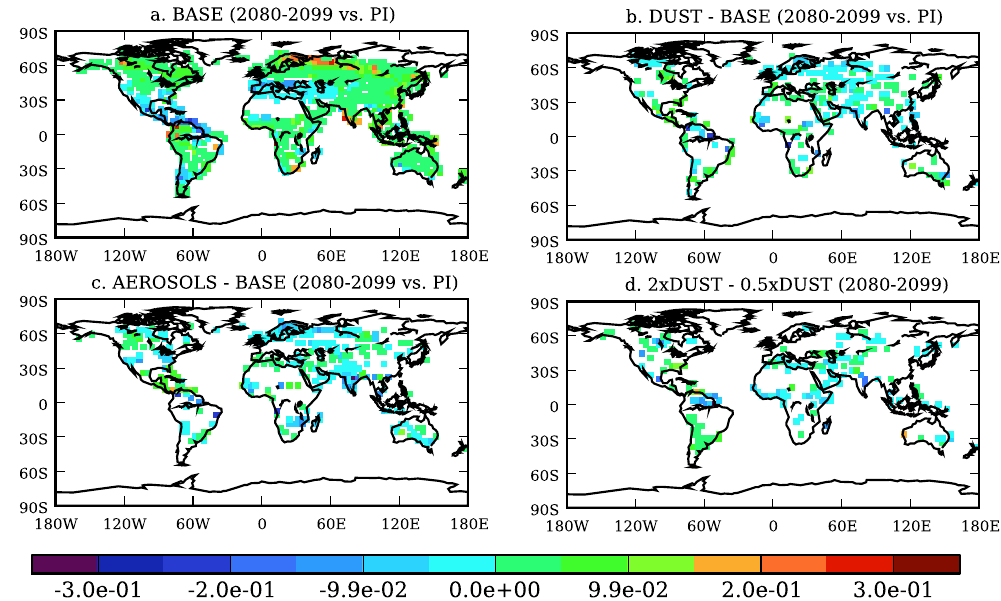
Fig. 12. Same as Fig. 11, but for Btran, a fraction indicating the level of moisture stress on photosynthesis (positive value means less moisture stress, while a negative value means more moisture stress).